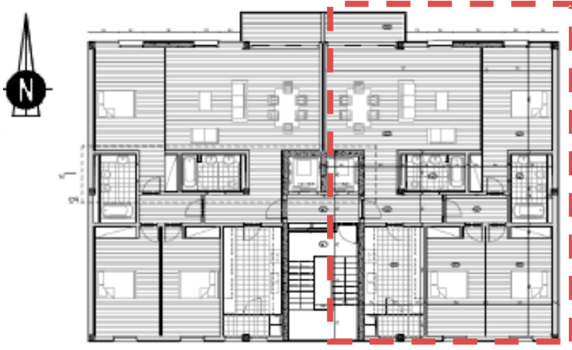
Figure 2. Residential model flat considered in this study (on the right).